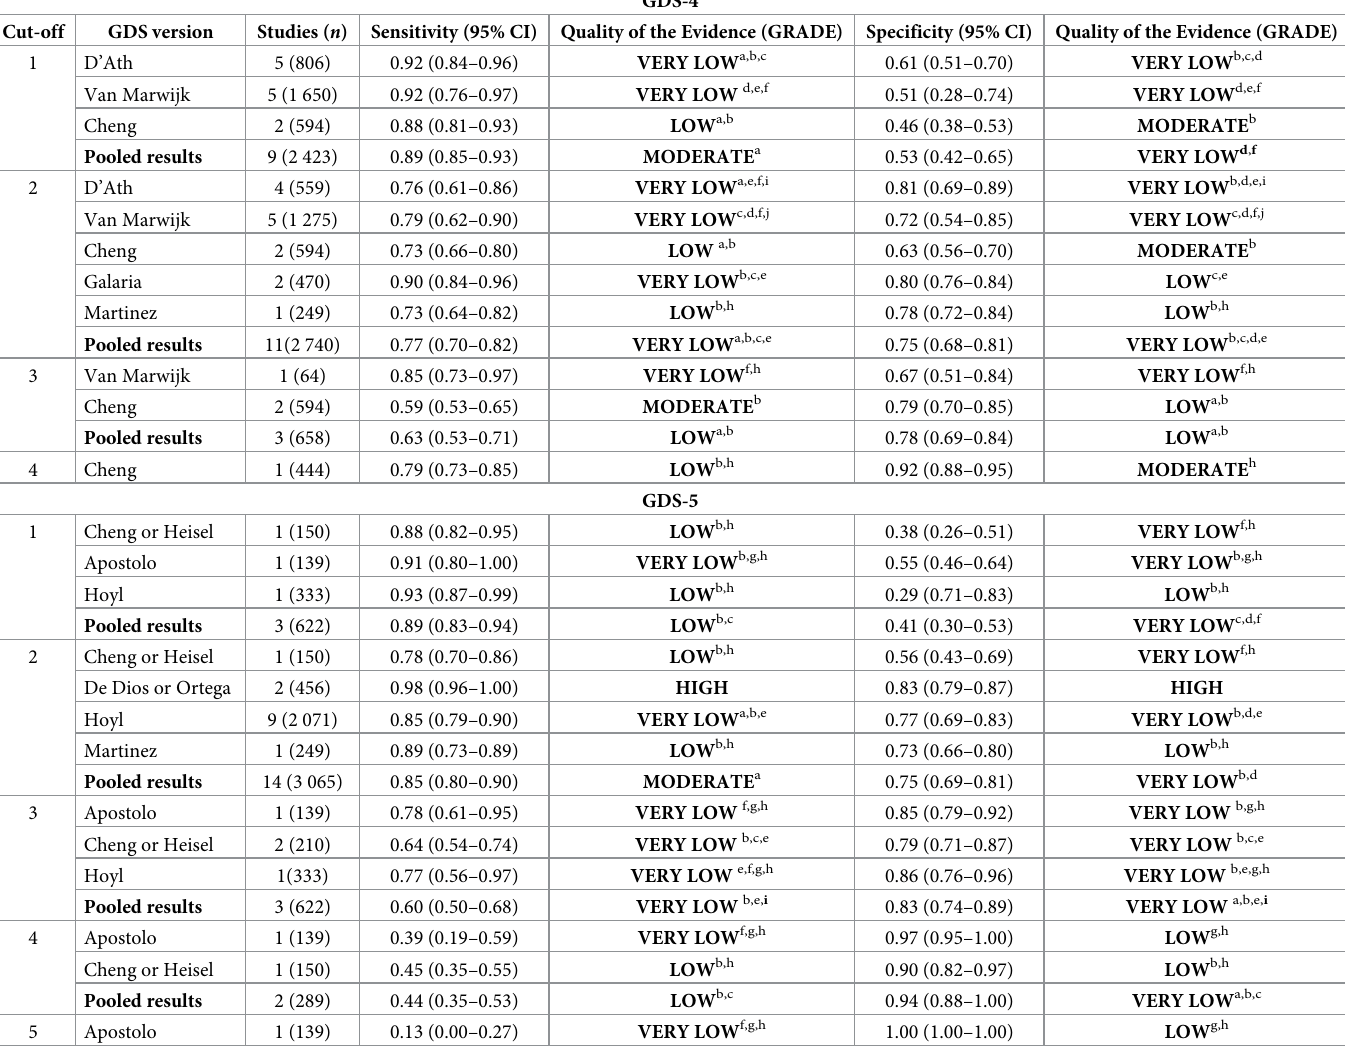
Table 3. Summary of diagnostic